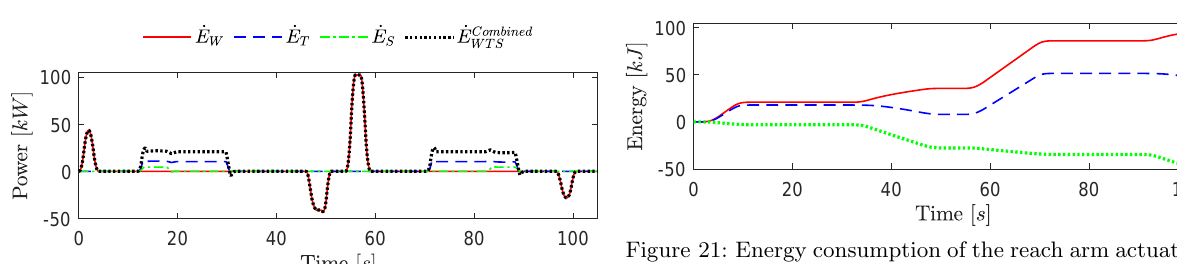
Figure 18: Main arm and guide arms; actuator output power.